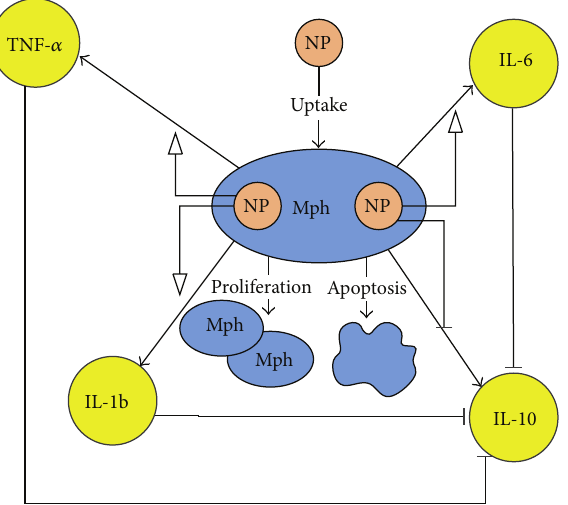
Figure 3: Schematic representation of macrophage dynamics involving proliferation, apoptosis, and cytokine secretion in vitro . (ThediagramfollowsthestandardsoftheSystemsBiologyGraphical Notation (SBGN); see